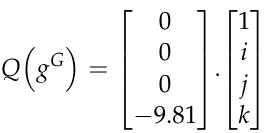
Figure 2. Marker placement over IMUs and